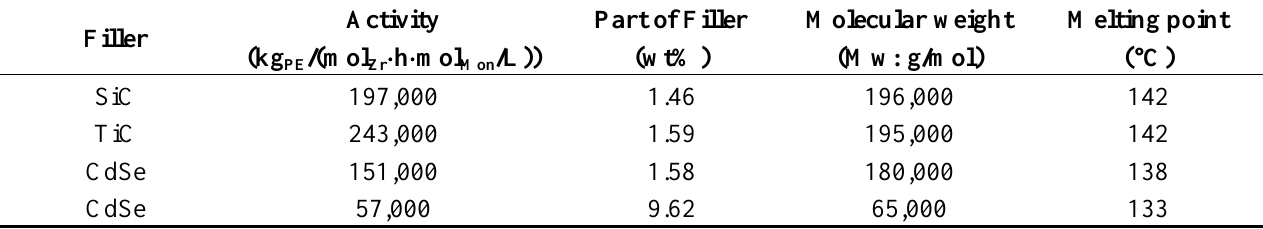
Table 1. Polyethylene nanocomposites prepared with different inorganic nanoparticles and different parts of filler by in-situ polymerization with metallocene catalysts.